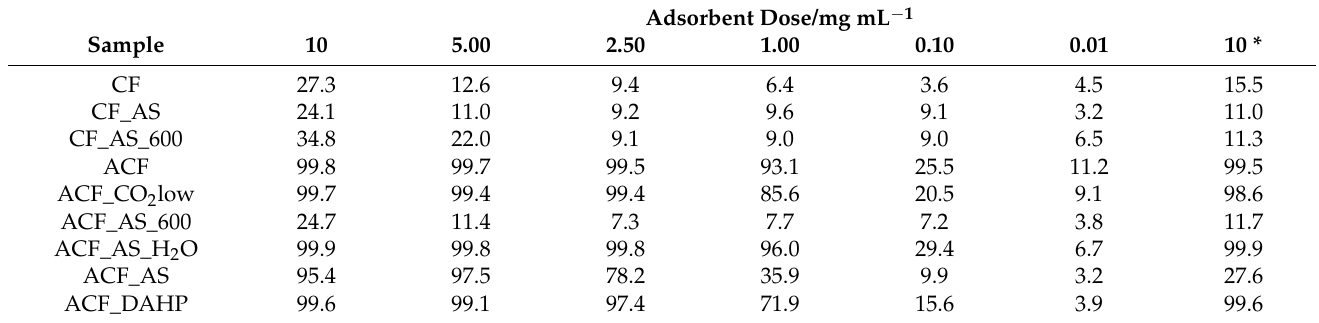
Table 5. Dimethoate uptake (in %) for the studied samples using different adsorbent doses. Un- certainties in the determined uptake did not exceed 8% of the measured values and were typically under